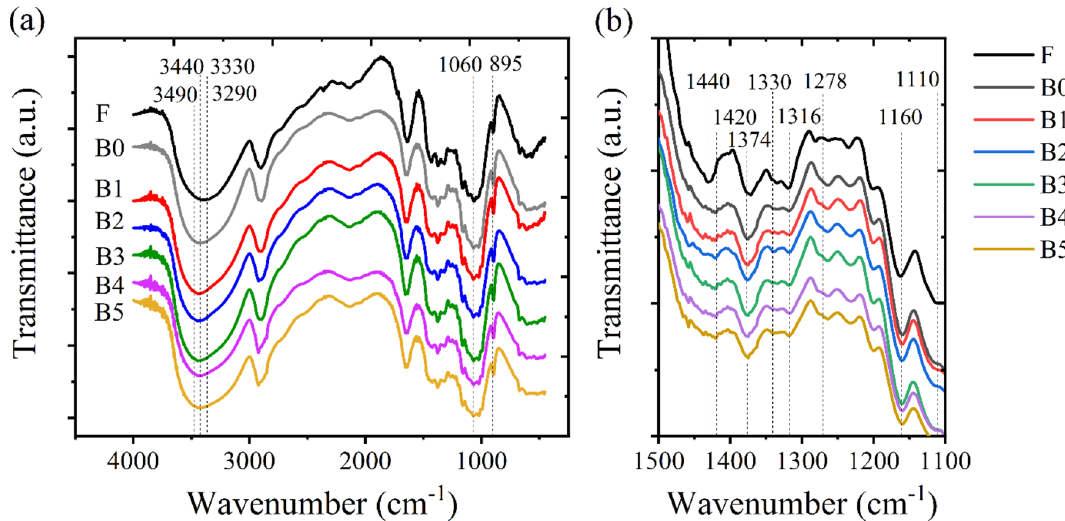
Figure 2. Fourier-transform infrared (FTIR) spectra of purified water hyacinth fibers (F) and cross-linked hydrogels with various concentrations of borax in the range of (a) 4,000 – 400 cm -1 and (b) 1,500 – 1,100 cm -1